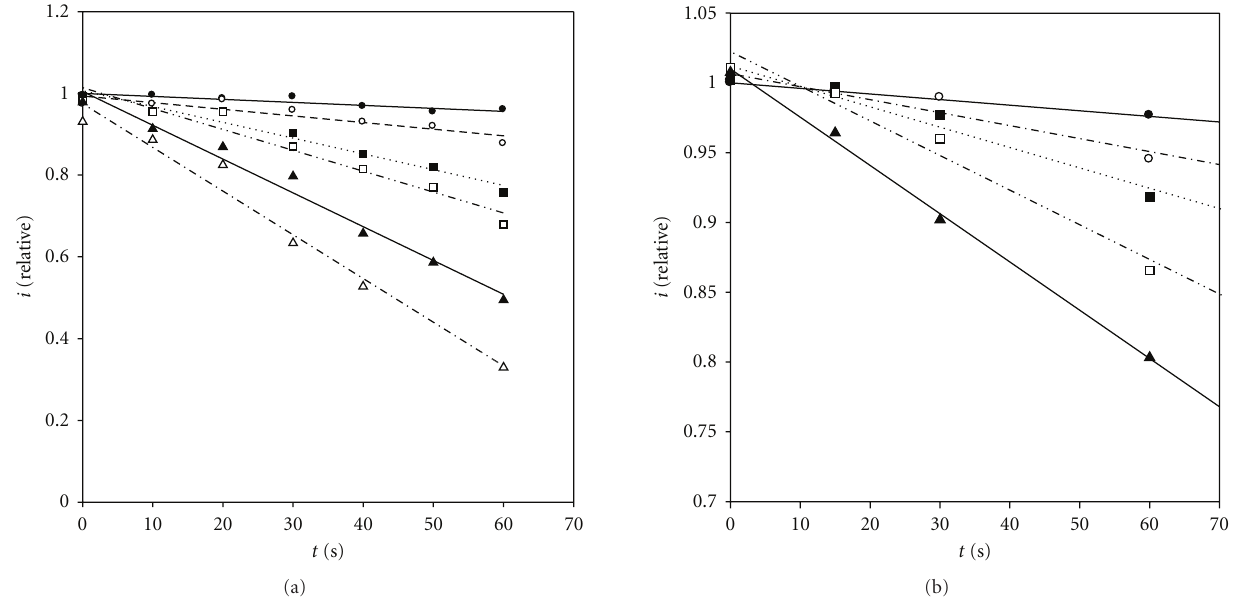
Figure 3: i ac (relative)- t curves obtained by dividing the results in Figure 2 by the value for supporting electrolyte at t = 0s.